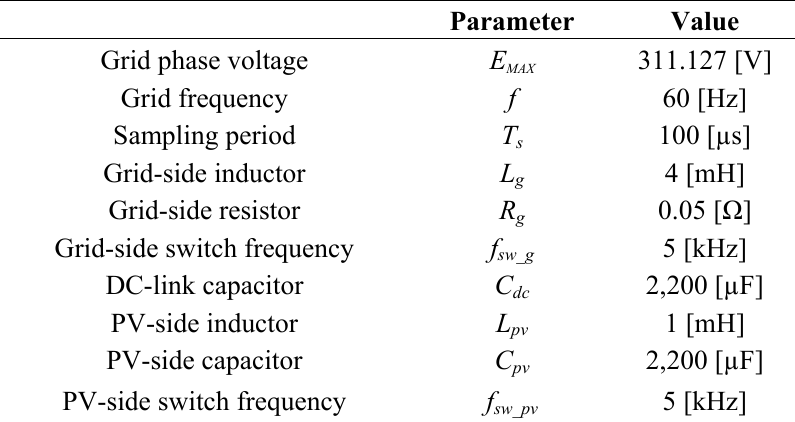
Table 1. Parameters of the